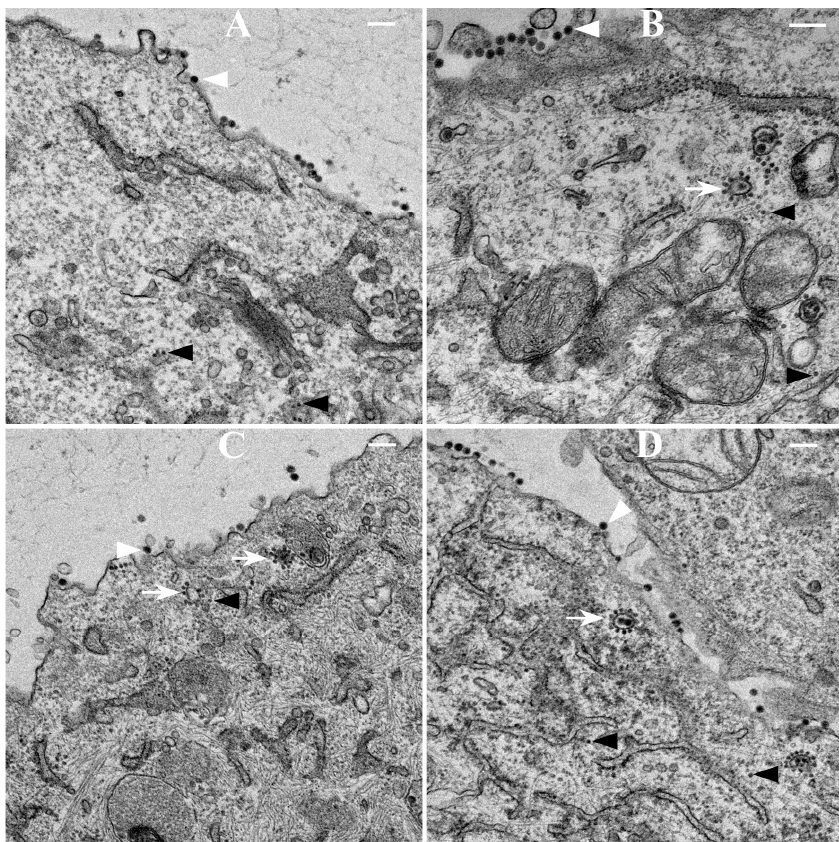
Figure 7. Transmission electron microscopy (TEM) analysis of SINV ‐ infected BHK cells. BHK cells were infected with WT or mCherry ‐ E2 virus at an MOI 5 and fixed for TEM analysis at 6 h and 12 h. p.i. Cells infected with WT (panel A 6 h; panel B 12 h) and cells infected with mCherry ‐ E2 (Panel C 6 h; panel D 12 h) viruses are shown. Budding viruses (white arrowhead), and nucleocapsid cores (black arrows) are marked. White arrows indicate type II cytopathic vacuoles (CPV ‐ II). Scale bars represent 200 nm.